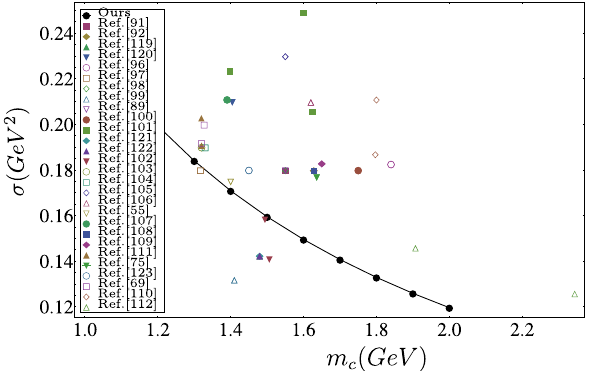
Fig. 5 Choice of parameters for various models incorporating the lin- ear potential or the screened linear potential. The joined black line (Ours) is for σ = β 3 / 2 /( 12 m c ) ( β = 2 . 02 GeV 2 ) which is from